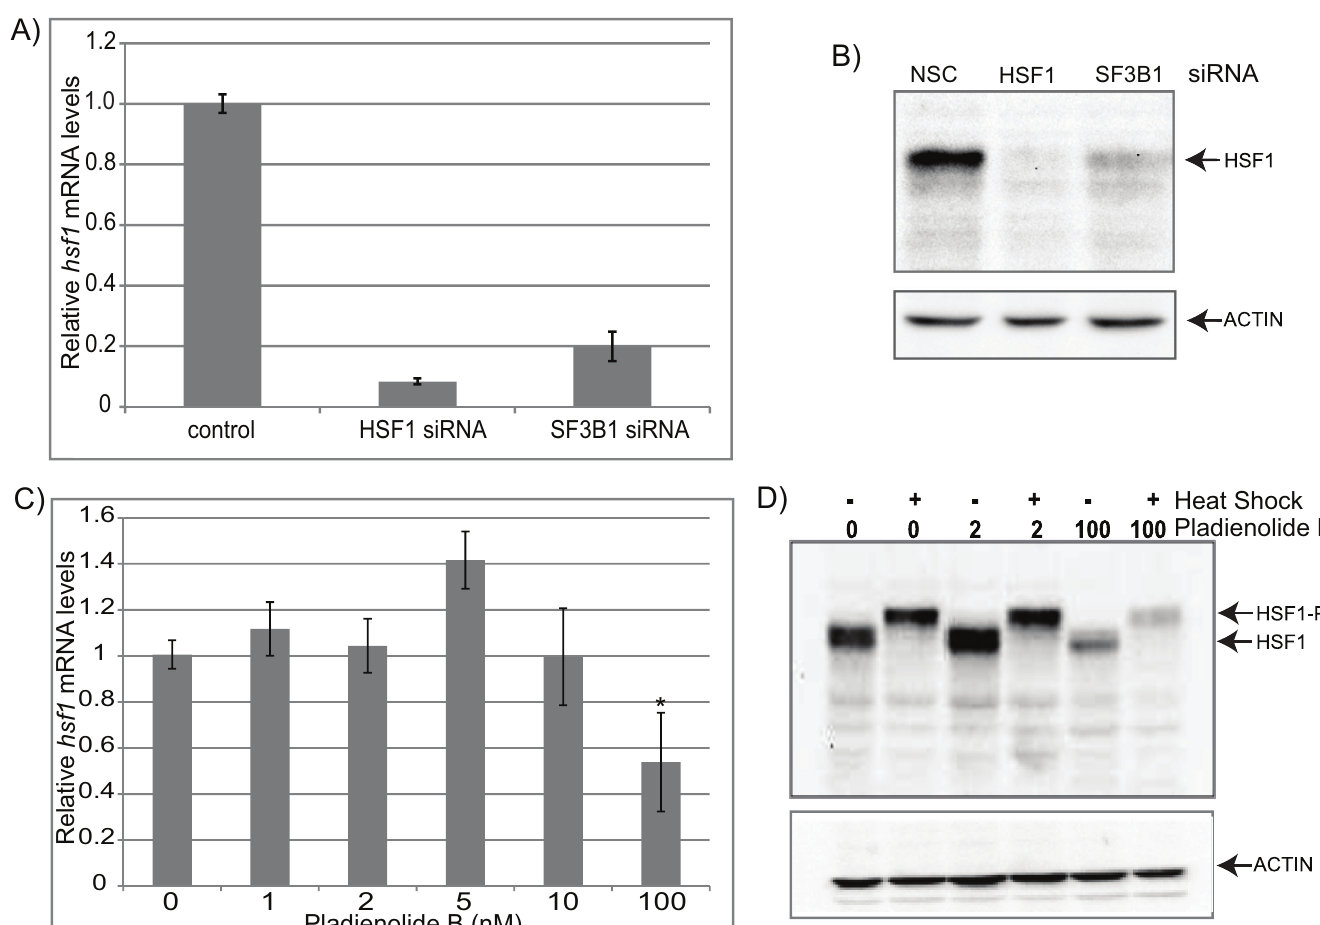
Fig 3. SF3B1 knockdown and high but not low levels of an SF3B1 inhibitor decreases HSF1 mRNA and protein levels. (A) qRT-PCR analysisof HSF1 mRNA levels in cells that have been treated with either HSF1 siRNA or SF3B1 siRNA relative to nonsilencing siRNA control cells. (B) Western blot analysisof cells that have been treated with non-silencing control siRNA (NSC), HSF1 siRNA, or SF3B1 siRNA and probedwith either anti-HSF1 or anti- ACTIN antibodies. (C) qRT-PCR analysisof HSF1 mRNA levels in cells that have beentreated with varyingamounts of Pladienolide B relative to control cells. (D) Western blot analysisof cells that have been treated with varyingamounts of Pladienolide B, with and without heat shock at 42˚ for 1 hour and probedwith either anti-HSF1 or anti-ACTIN